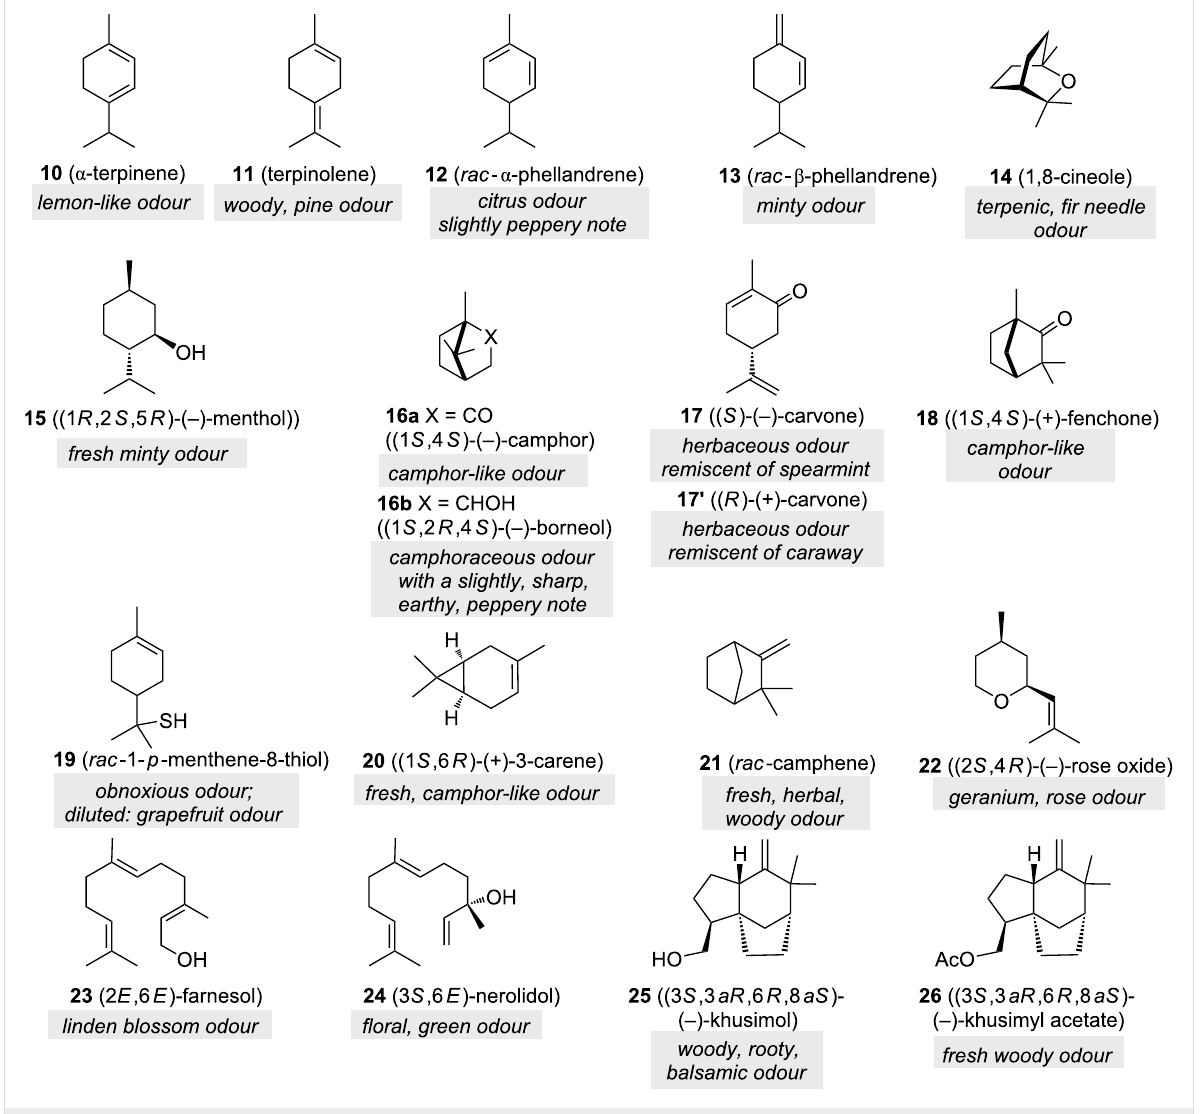
Figure 2: Other selected mono- and sesquiterpenes ( 10 – 26 ) as fragrance materials [6].